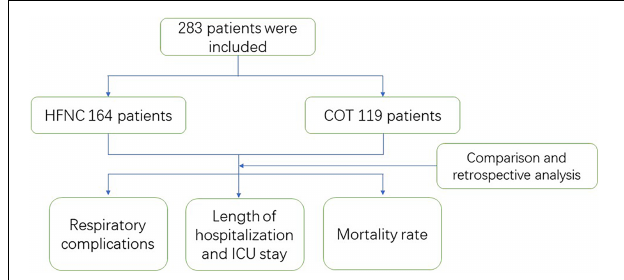
FIGURE 1 | Study flow chart. HFNC, High flow nasal cannula; COT, Conventional oxygen therapy.